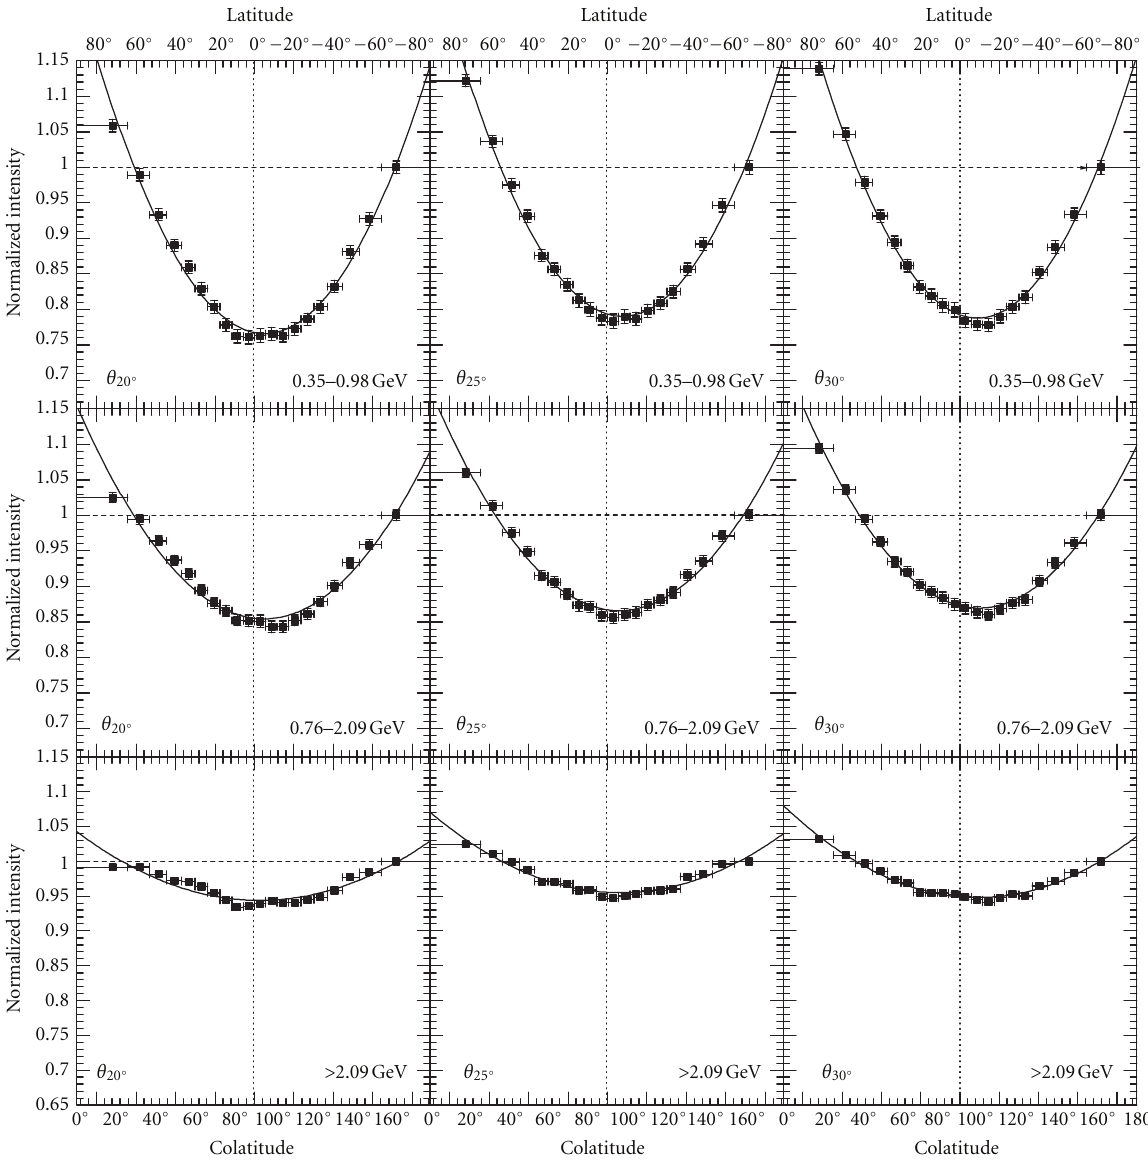
AU, obtained at different solar colatitudes for protons in the energy range de�ned in the , , and 𝑟𝑟 𝑟 𝑟 ∘ ∘ ∘ 𝜃𝜃 25 𝜃𝜃 30 𝜃𝜃 20